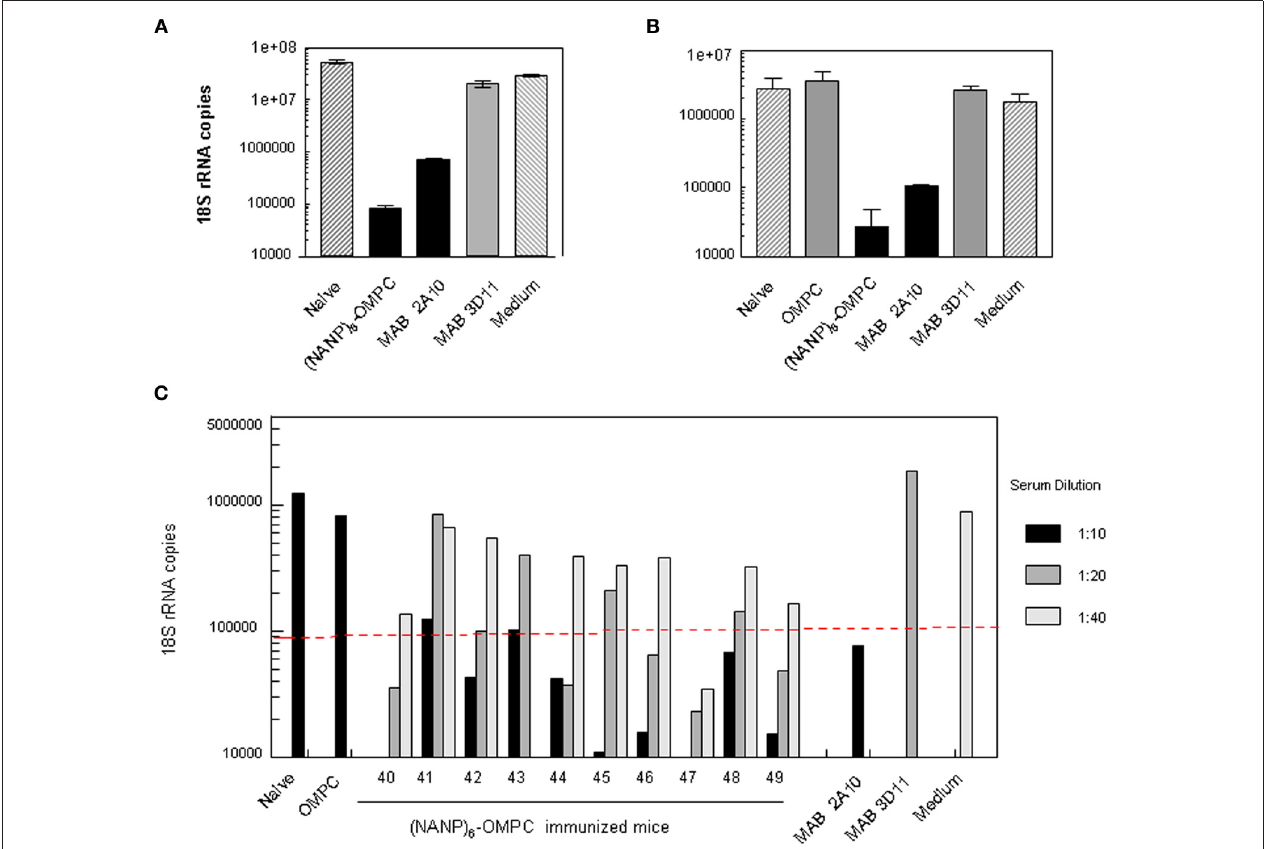
FIGURE 4 | Sporozoite meutralizing activity in murine immune serum. Sera from (A) Balb/c or (B) C57Bl /6 mice immunized with three doses of (NANP) 6 -OMPC/MAA were tested in TSNA. PfPb sporozoites, that express P. falciparum CS repeats, were incubated with immune or control sera (1:5 dilution) prior to addition to HepG2 cells. Levels of parasites in HepG2